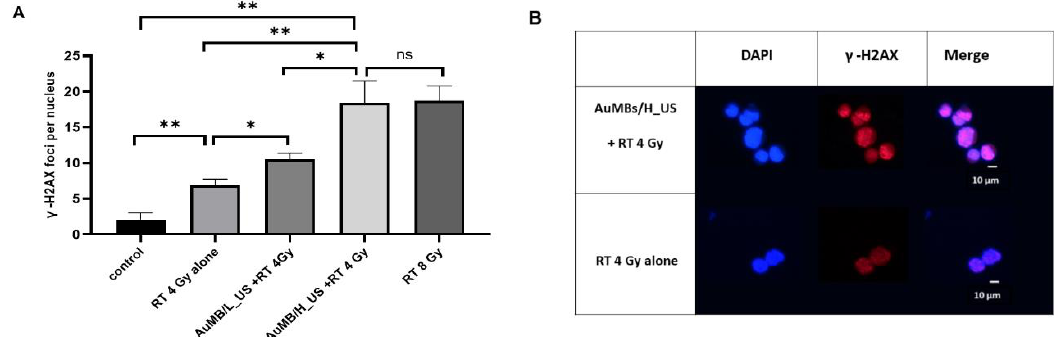
Figure 6. ( A ) The number of γ-H2AX foci were counted in 50 cells at 1 h after the treatment. Data are mean and SD values for the number of foci per cell in each group from three independent experiments. * p < 0.05, ** p < 0.005. ( B ) Representative graphs of Huh-7 cells at 1 h after the treatment of radiotherapy (RT) with or without preceding AuMB-sonoporation. Cells were stained with γ - H2AX and 4’,6-diamidino-2-phenylindole